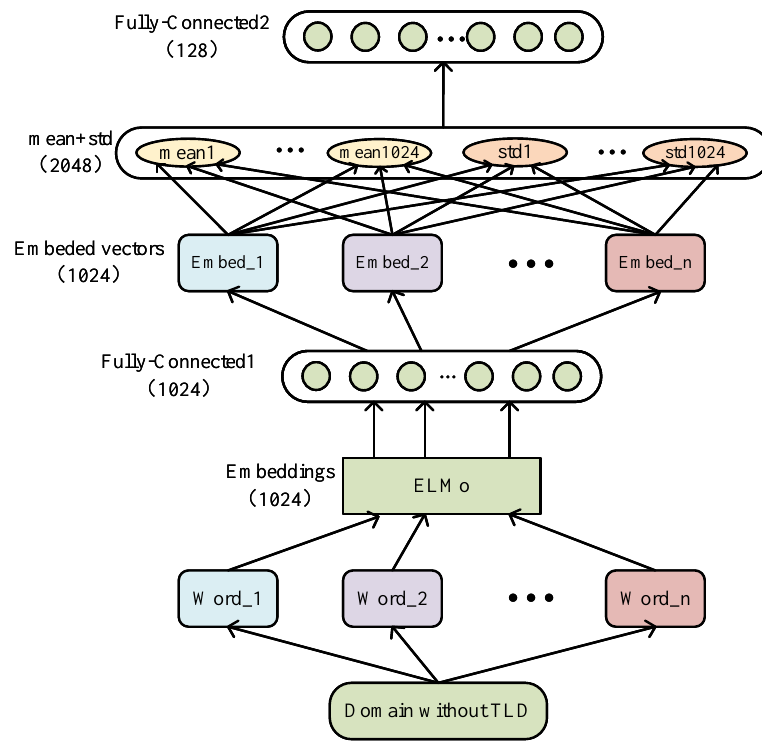
Figure 3. Process of word distribution feature